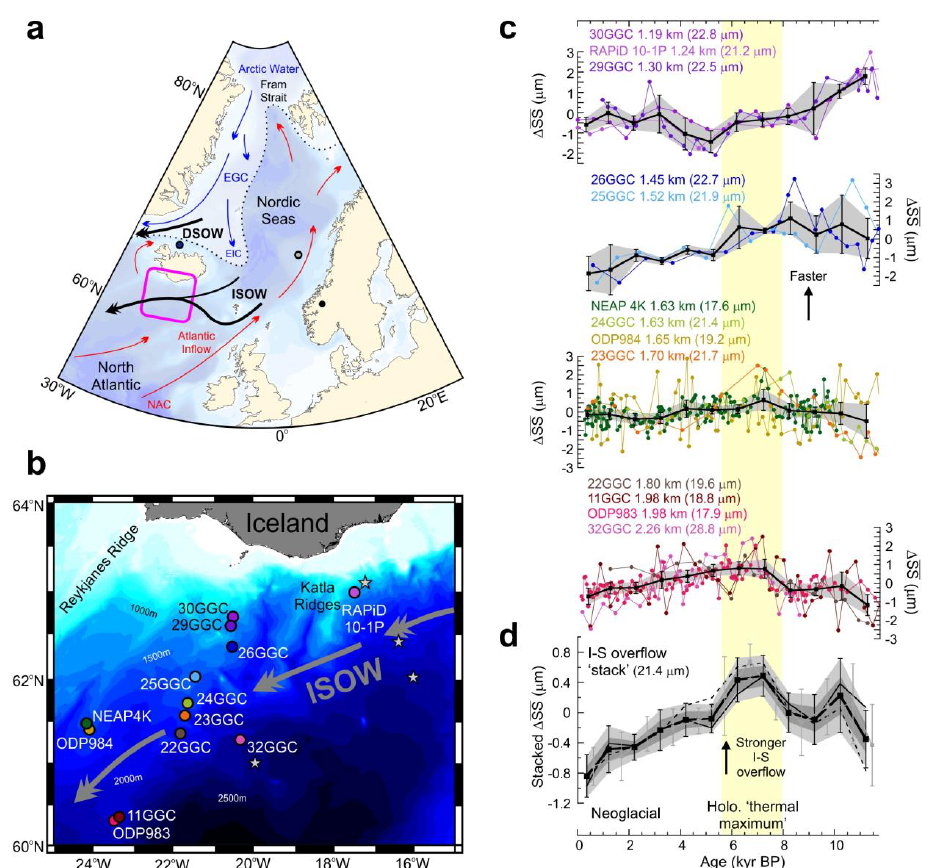
Fig. 1. (a) Regional map: thin red arrows are warm surface Atlantic waters; thin blue arrows are cold, fresh sea ice bearing Arctic surface waters; thick black lines are deep overflow pathways; purple square is the South Iceland Rise, ISOW flow speed proxy data; blue circle is the North Iceland drift-ice study site; grey circle is the Norwegian Sea sea-surface temperature study site; black circle is the Norwegian glacier record). (b) Map of core sites (see Table S2 for details): grey stars indicate the location of current meters used in SS core-top calibration (note that one additional site lies to the east of this map view). The main flow of ISOW is concentrated at 1400–1800m over the East Katla Ridge (Shor, 1980) and at ∼ 1800m water depth over Bjorn Drift ( ∼ 22–24 ◦ W) (Bianchi and McCave, 2000). (c) Down-core changes in SS divided into 4 groups according to water depth (1200–1375m, 1375–1575m, 1575–1750m, and 1750–2250m). To enable comparison between cores, data are plotted with the mean Holocene value for each core (provided in parentheses) set to zero. Thick black line and symbols in each depth group illustrates the long-term trends described by the 1000yr “binned” data, with standard error bars ( ± 2SE). (d) Stacked data represent the relative strength of the Iceland–Scotland overflow, weighted according to the approximate depth interval each group represents (i.e. a weighting for the 4 groups, from shallow to deep, of 1.75, 2, 1.75, and 5). Error bars ( ± 2SE) are calculated by propagating the standard errors from the grouped data, light grey shading ( ± 2SE), dark grey shading ( ± 1SE). Thin grey line and grey symbols (with accompanying grey ± 2SE error bars) is the “stack” obtained by offsetting the 1000yr bin windows by 500yr (see Fig. S1). Dashed line is the weighted average only using cores > 1.3km, the depth influenced by the modern I–S overflow (Bianchi and McCave, 2000); whilst the thin black line is the “stack” obtained from simply averaging the data from all the cores individually, rather than taking a weighted average of the 4 different depth 22